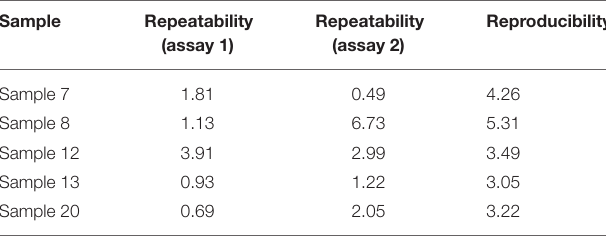
TABLE 2 | Repeatability and reproducibility of BMSB assay, measured as percentage coefficient of variation